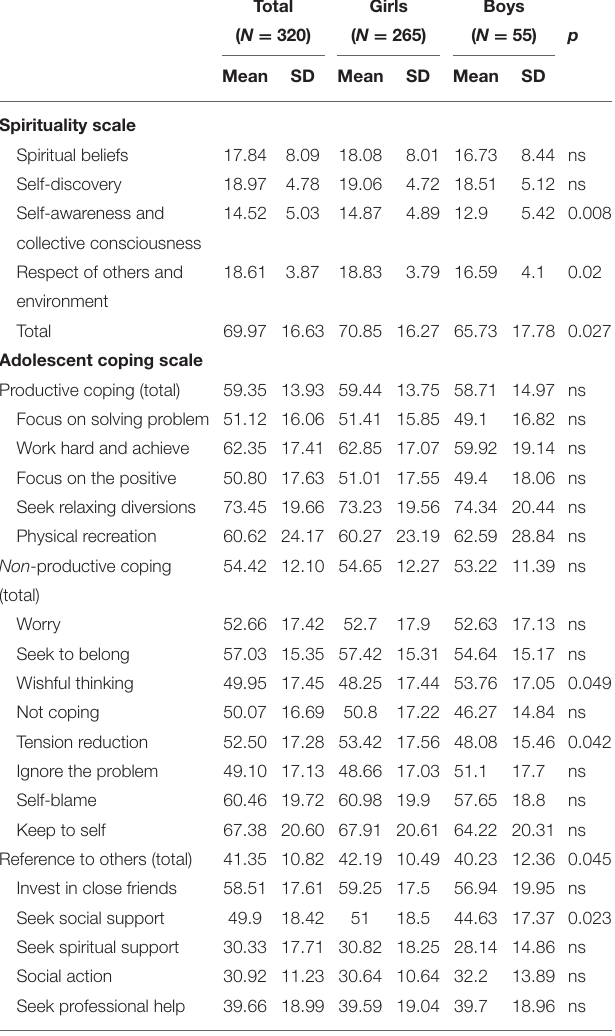
TABLE 4 | Individual protective factors and comparisons by gender (Wilcoxon Rank-Sum